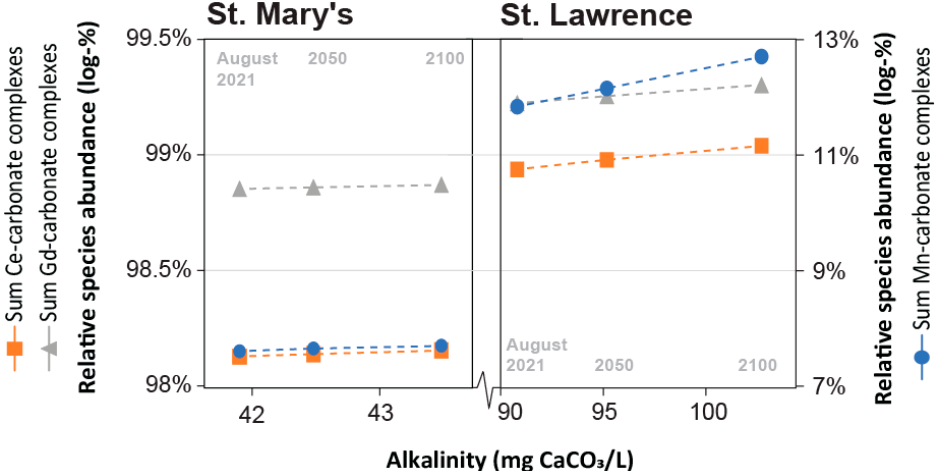
Figure 5. Geochemical equilibrium modelling of the relative abundance of aqueous carbonate complexes of Ce and Gd (left y-axis) and Mn (right y-axis) in the St. Marys (upstream, left panel) and St. Lawrence (downstream, right panel) rivers in the Great Lakes basin. Plotted is the combined share of all carbonate-complexed aqueous species per-total (molality basis) as a function of alkalinity (intersected x-axis).